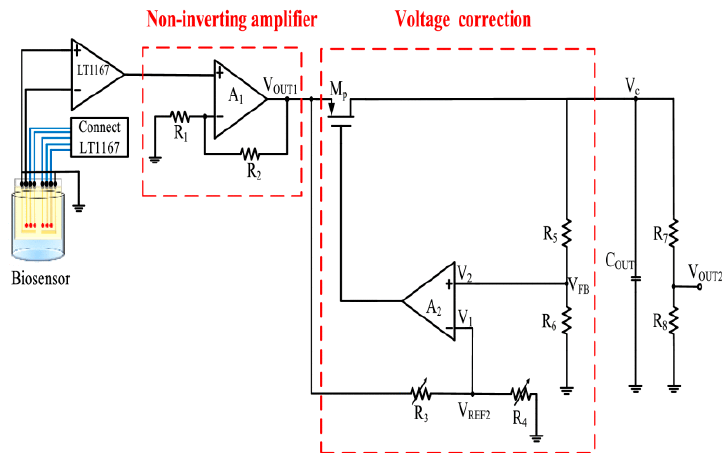
Figure 8. Circuit diagram of the calibration readout circuit for the hysteresis effect [16].